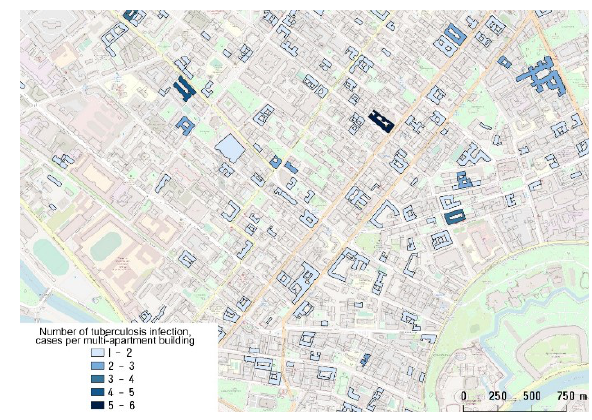
Figure 5 . Example of tuberculosis infection cases map (number of cases per multi-apartment